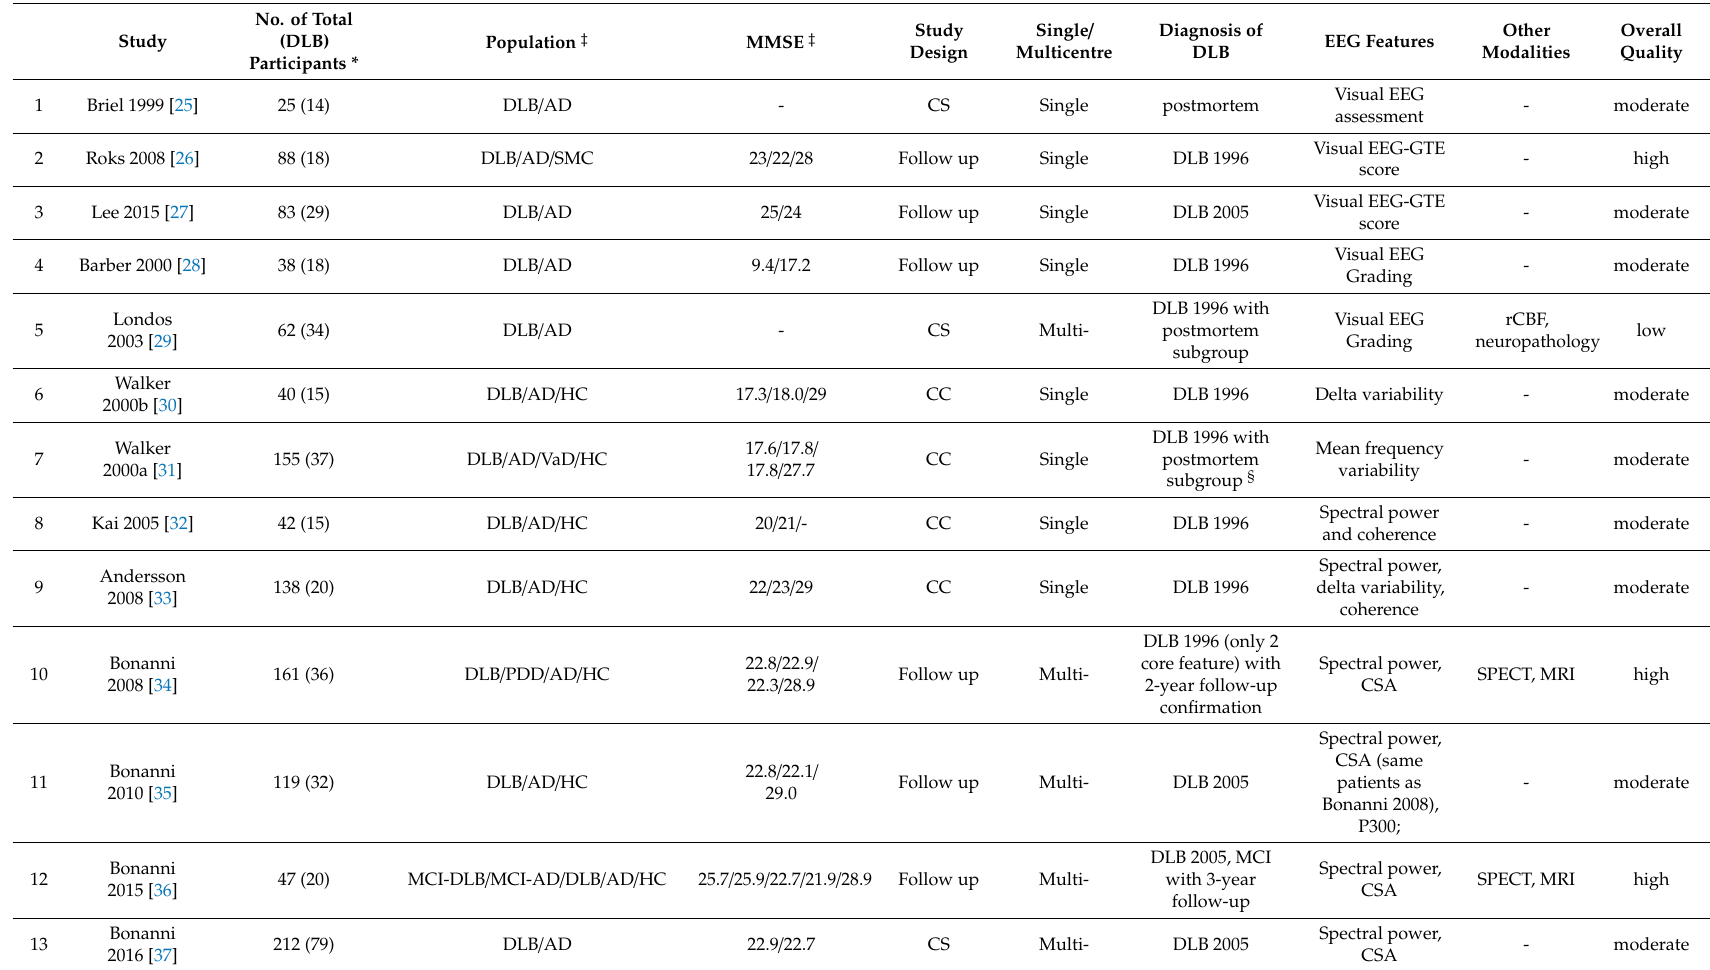
Table 1. Characteristics of included